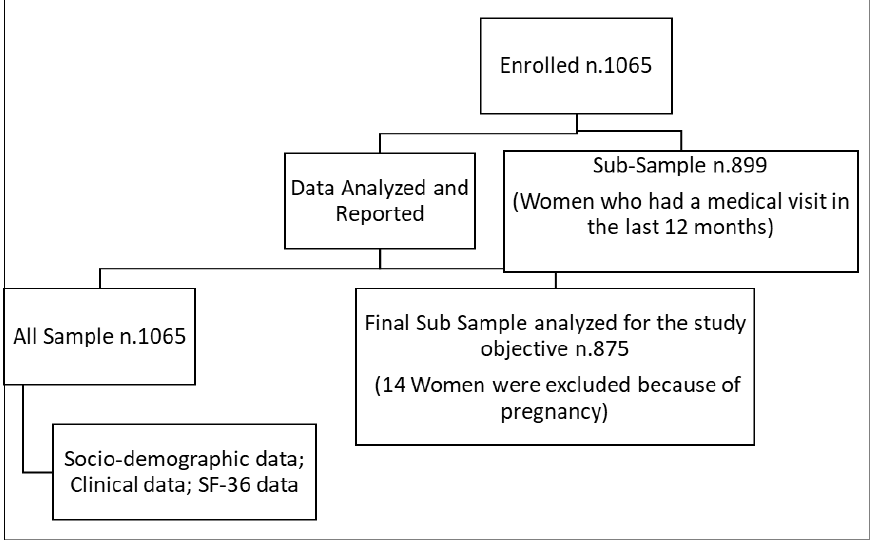
Figure 1. Flow chart diagram.